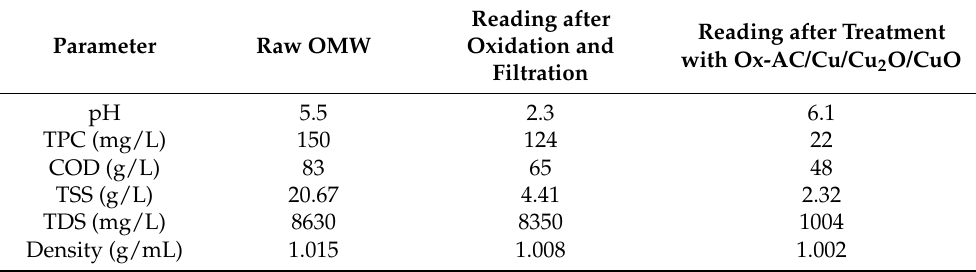
Table 6. The major characteristics of OMW samples. Parameter Raw OMW